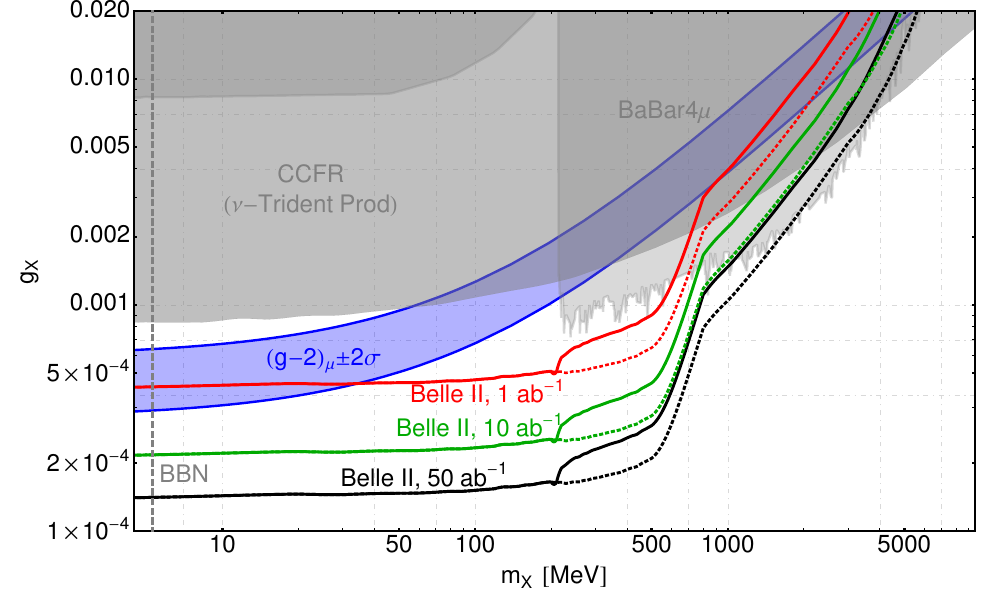
Figure 12 . Sensitivity limit, using (cid:22) + (cid:22) (cid:0) +INV channel, corresponding to heavy masses of X gauge boson ( m X > 2 m (cid:22) ). Red, green, black solid lines are 1, 10, 50 ab (cid:0) 1 search for minimal L (cid:22) L (cid:28) case (which has no additional decay channel to dark sector) and dotted lines (cid:0) indicate Br( X invisible) 1 ! ’